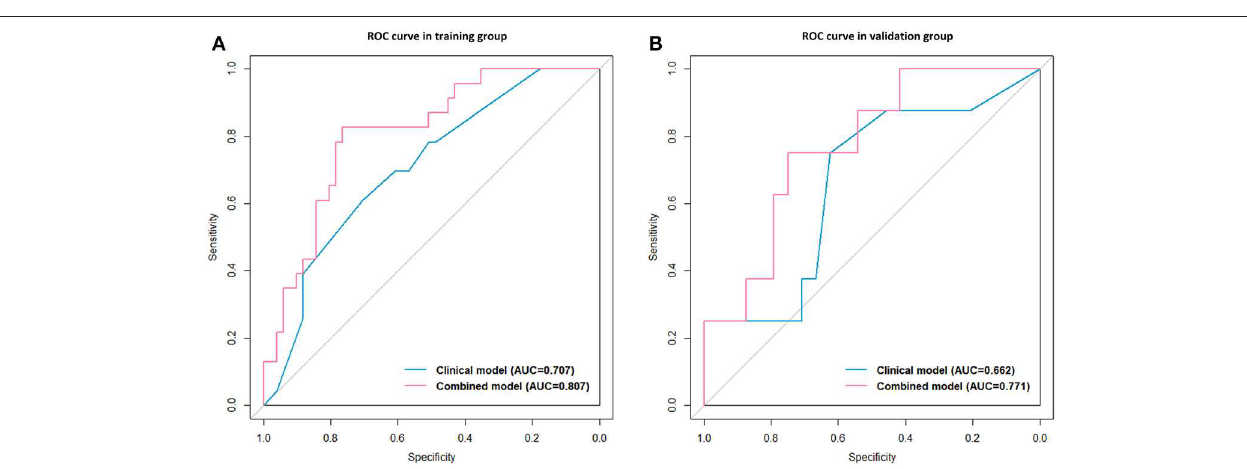
FIGURE 3 | Receiver operating characteristic (ROC) curves with the area under the curve (AUC) for the predictive performance for 3-month RFS. Clinical model vs. combined model in the training group (A) and the validation group (B) .